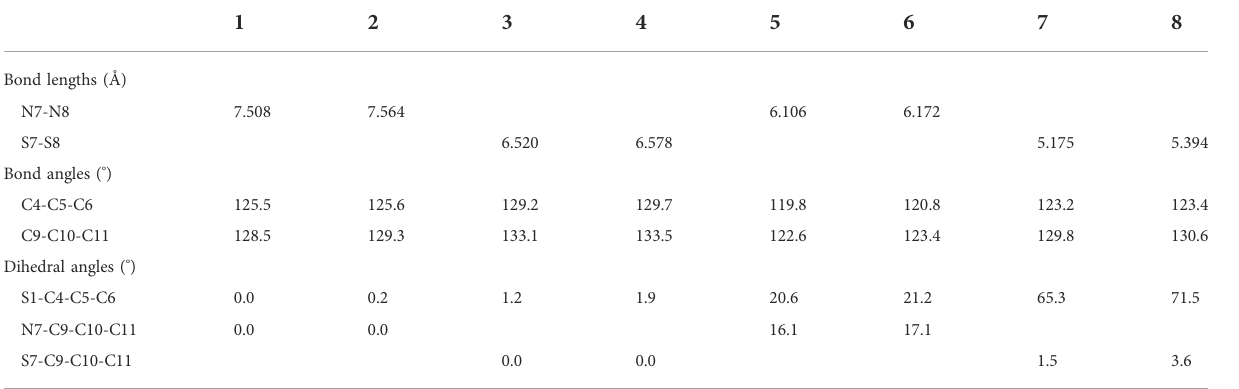
TABLE 1 Main optimized geometry structure parameters of 1 –